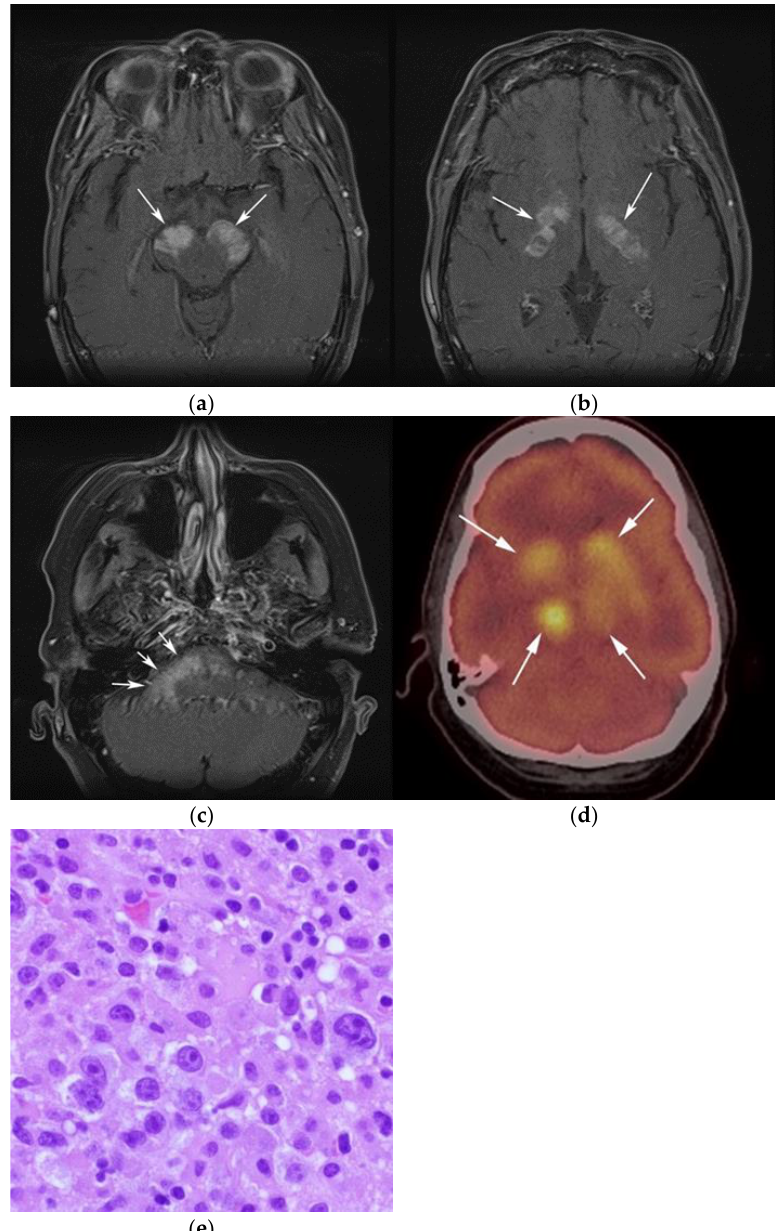
Figure 3. Same MRI series. ( a ) Axial post-contrast MRI image shows lesions extending caudally to involve the bilateral superior cerebral peduncles and anterior aspect of the mid-brain. ( b ) Axial MRI T1 post-contrast fat-saturated images show involvement of the posterior limb of the internal capsule and the thalami bilaterally (white arrows). ( c ) Extension along the lateral aspect of the pons, dentate nucleus, and the middle cerebellar peduncles (white arrows). ( d ) Axial FDG fused PET/CT image shows increased activity in the aforementioned lesions. Additional hypermetabolic lesions are seen along the course of the corticospinal tract (white arrows). Imaging findings and pattern of involvement are consistent with lymphomatosis cerebri. ( e ) H&E section shows a tumor composed of large and pleomorphic cells with intermingled small lymphocytes. Primacy CNS lymphoma typically demonstrates an angio-centric predilection. (Original magnification 400 × , H&E stain). Other differential diagnoses include a vasculitic process, toxic or metabolic encephalopathy, paraneoplastic syndrome, or acute disseminated encephalomyelitis. Biopsy showed a large non- cohesive B-cell lymphocyte population consistent with